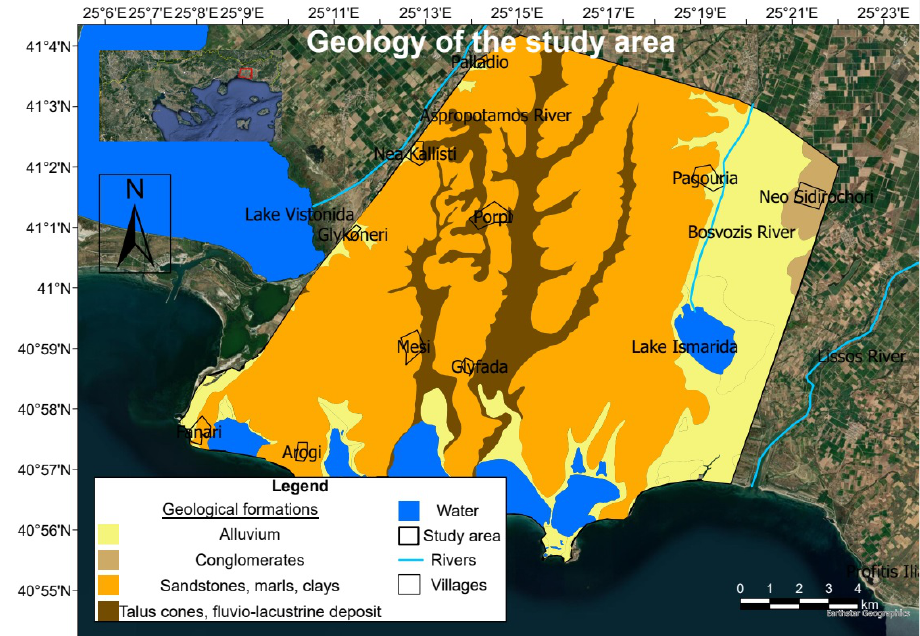
Figure 2. The geological formations of the study area